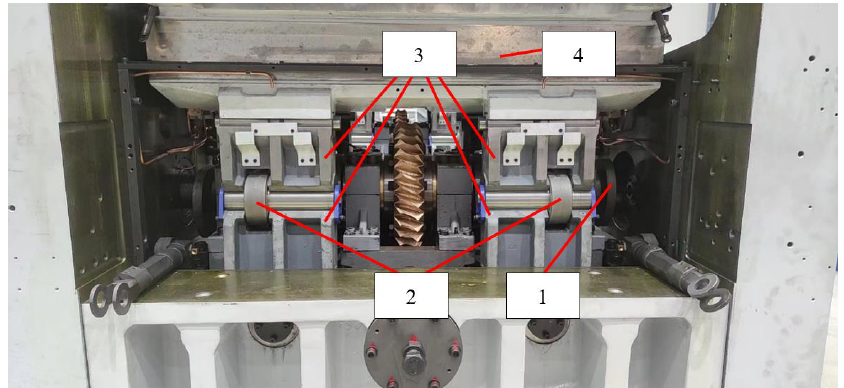
Figure 34. Application diagram of fully symmetrical lightweight drive rod. 1—crankshaft; 2— power rod; 3—lightweight drive rod; 4—moving platform. rod; 3-lightweight drive rod; 4-moving